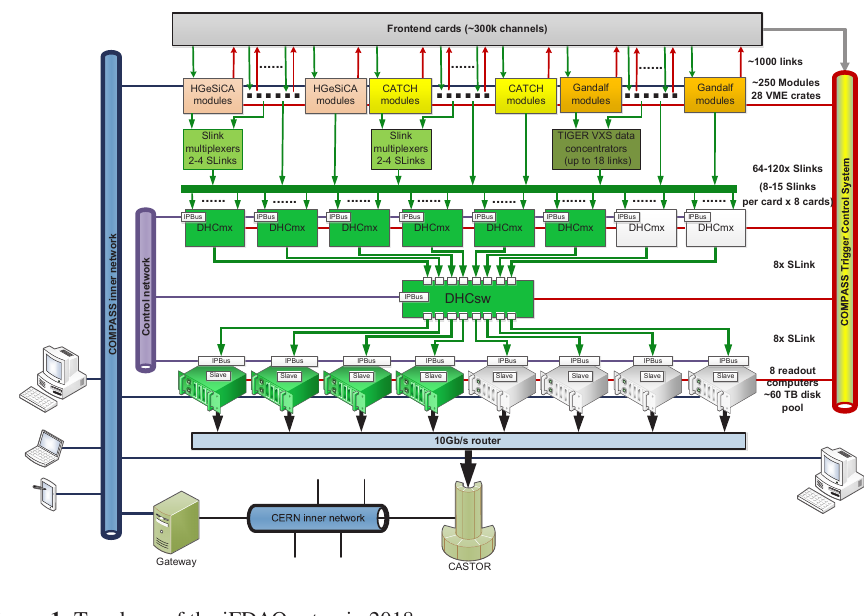
Figure 1. Topology of the iFDAQ setup in